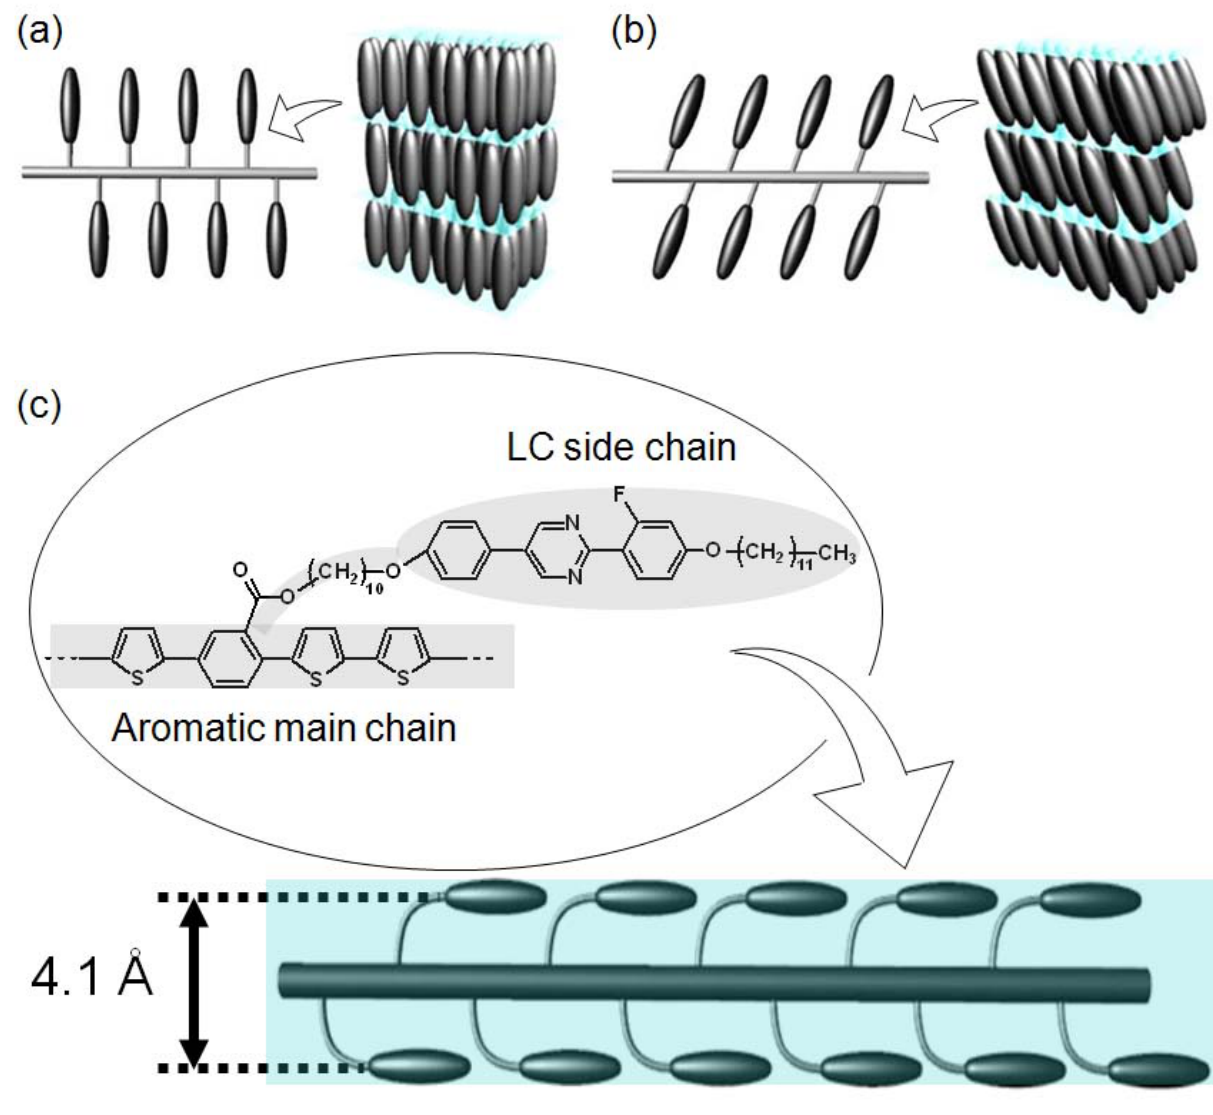
Figure 8. Possible structures of LC polymers: (a) SmA phase, (b) SmC phase, (c) N phase (inter-molecular distance (4.1 Å) was determined by x-ray